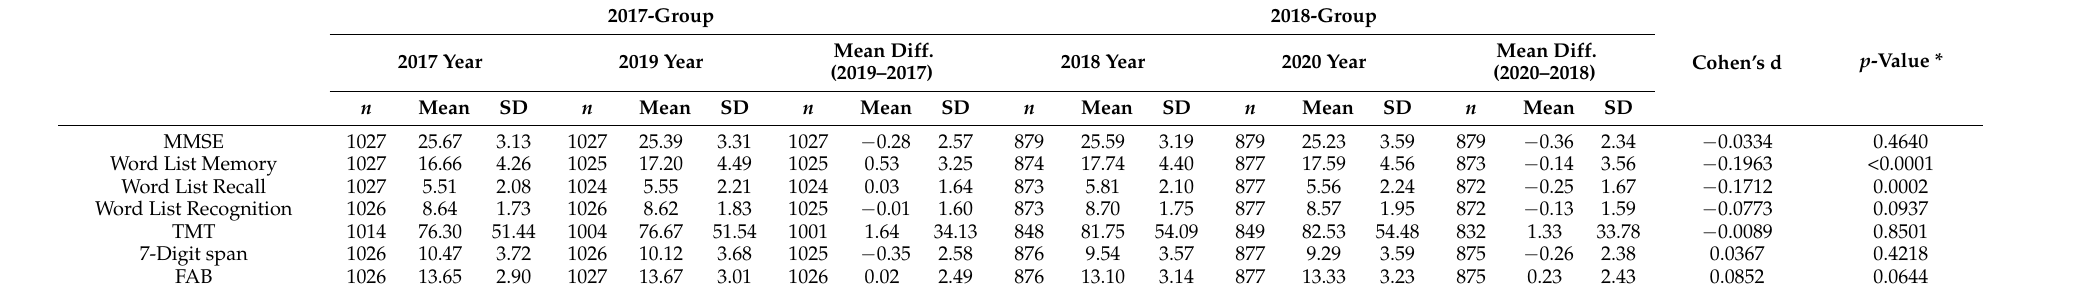
Table 2. Unadjusted mean differences of cognitive function during 2 years in 2017-Group and 2018-Group (intergroup comparison).